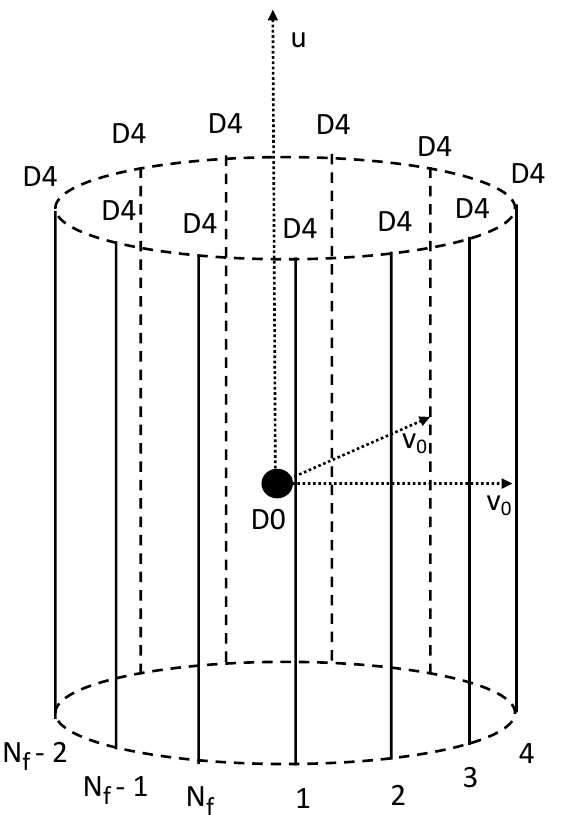
Figure 1 . The D0-branes at the origin are surrounded by uniform density of D4-branes separated in the R 5 transverse to the D4-branes and a distance v = v 0 from the